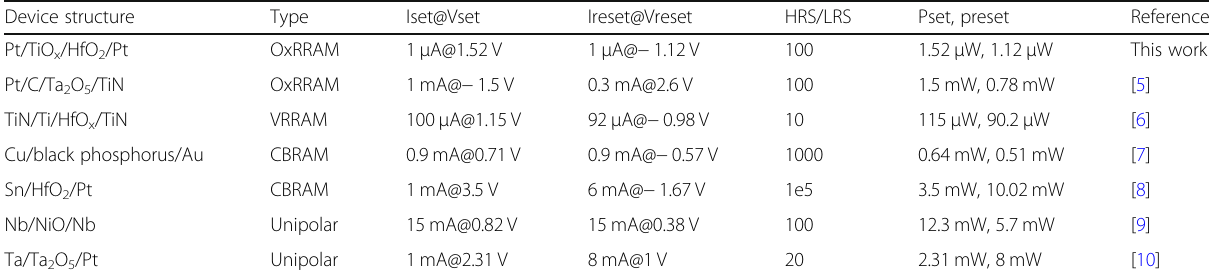
Table 3 Comparison of device performance for RRAM devices Device structure